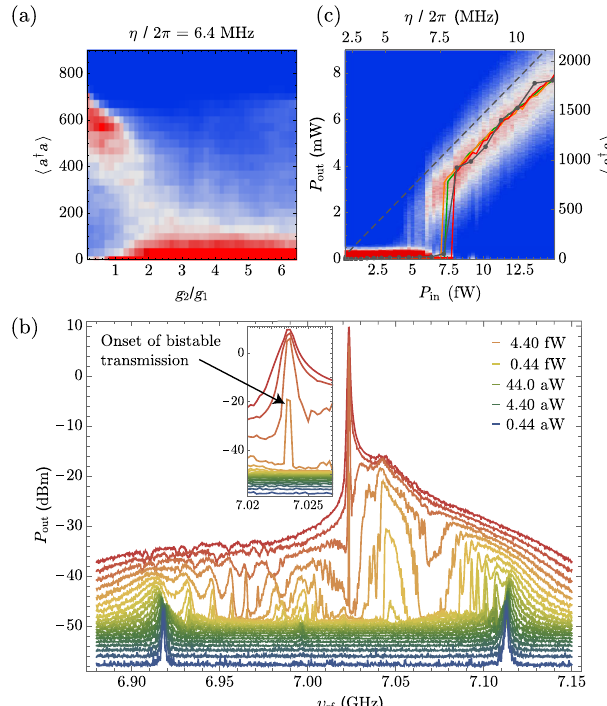
FIG. 3. (a) Simulated histogram of the output intensity as a function of the coupling constant g 2 between the two excited atomic states j e i and j f i for η = ð 2 π Þ ¼ 6 . 4 MHz, with red representing high probability and blue indicating zero proba- blility. (b) Measured vacuum Rabi spectra for input powers from 0 . 44 × 10 − 18 W (blue) to 25 × 10 − 15 W (red) with all three P in ¼ atoms in resonance with the cavity. P and P refer to the cavity in out input power and digitizer input power, respectively. For better visibility the shown spectra are offset by 1.6 nW from each other. The sharp transmission peak shown in the inset appears stochas- tically. In this particular measurement (orange line at 4.4 fW input power), we observe only two frequency points with small but finite switching probability and we sample over multiple switch- ing events resulting in a certain mean detected power. At lower drive power no transmission is observed (no switching). At higher drive powers the transmission peak approaches the cavity linewidth and scales linearly with input power (no switching again). (c) Measured histogram of the detected power as a function of the cavity input power for a single transmon (density plot). The most likely photon numbers (line plots) are extracted from this measurement (red) and two similar measurements taken with 2 (orange) and 3 qubits (green) in resonance with the cavity mode. Simulation results for the single qubit case are shown with connected black symbols for comparison. The dashed line is for reference and represents the response of the empty cavity with h a † a i ¼ ð 2 η = κ Þ 2